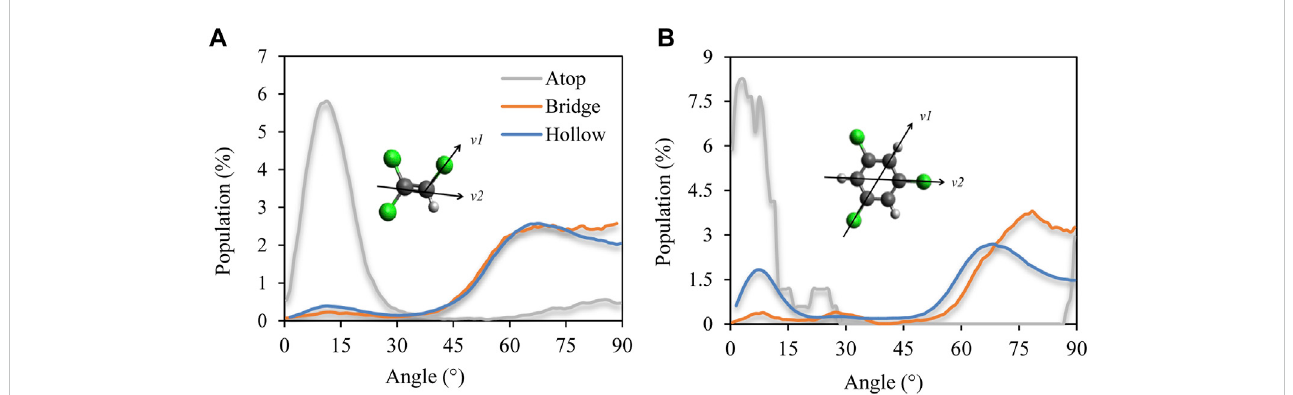
FIGURE 11 Adsorption site decomposition of distribution of angles between the molecular face-normal vector (de fi ned by the cross product of vectors v1 and v2) and the surface perpendicular, or z -axis, for Pd {110} as a representative case. Data for (A) TCE at 230 K and (B) for TCB at 360 K. Zero degree implies average parallel orientation with respect to Pd surface while 90 degrees implies perpendicular (standing)